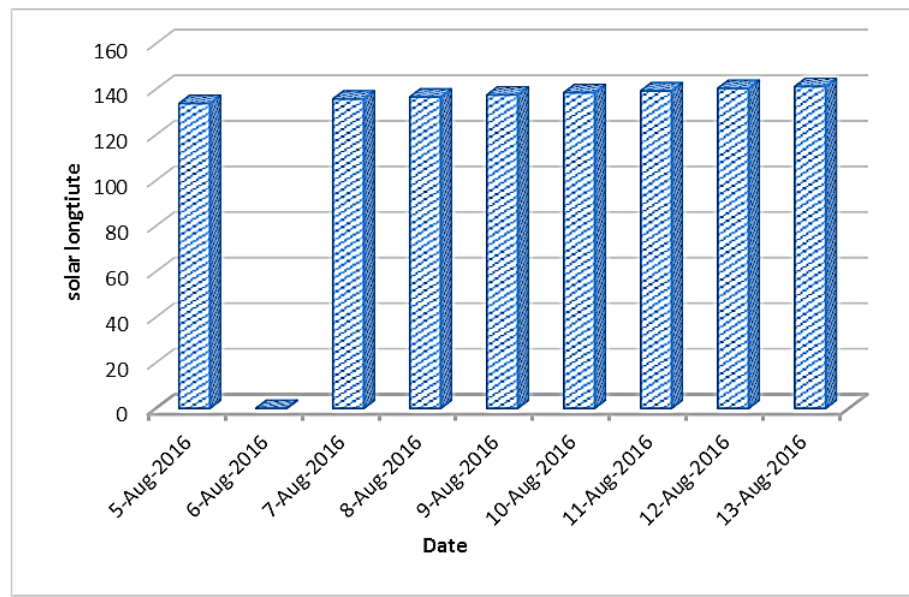
Fig. 2 The solar longitude distribution during 5-13 August